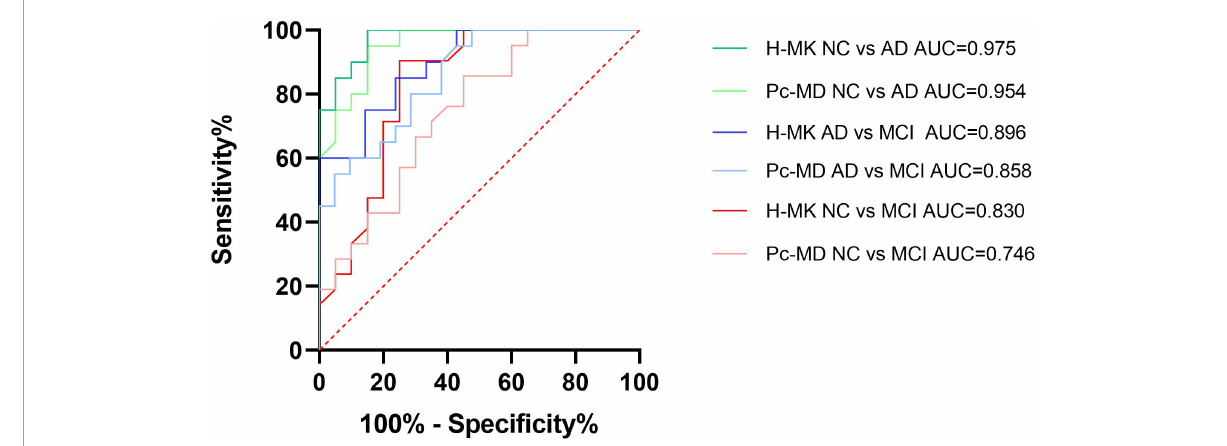
FIGURE7 Receiver operating characteristic (ROC) curve analysis of hippocampus MK and precuneus MD. Both parameters could be used to identify any two groups of patients, although hippocampal MK performed better than precuneus MD as reflected by its larger AUC. H-MK, mean kurtosis of hippocampus; Pc-MD, mean diffusivity of precuneus; NC, normal cognition; AD, Alzheimer’s disease; MCI, mild cognitive impairment; AUC, area under the